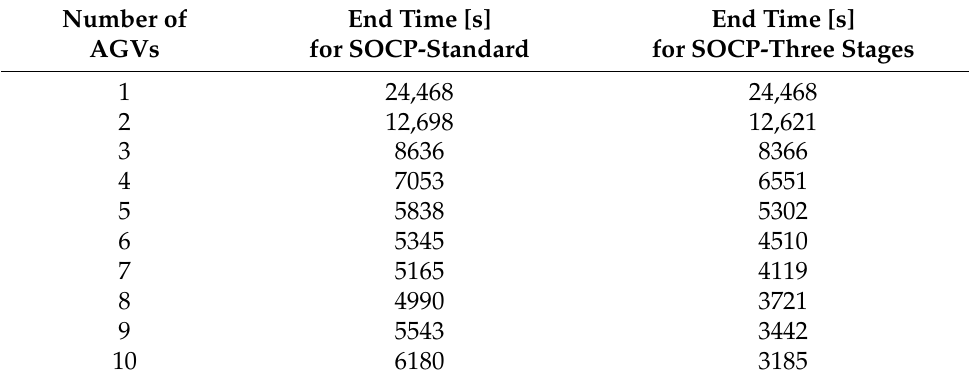
Figure 5. The layout with unidirectional flow paths. Table 3. The results of the simulation (unidirectional